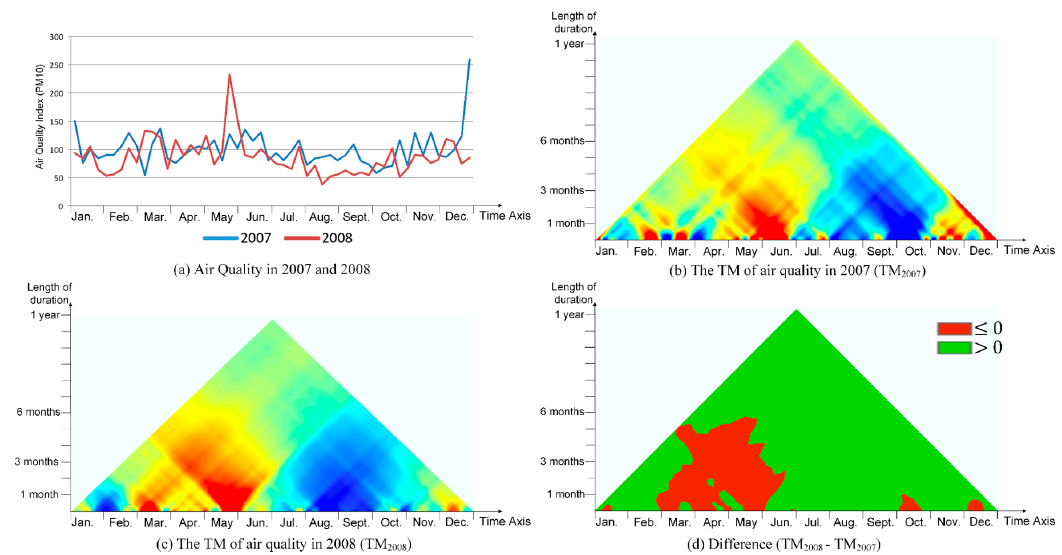
Figure 13. Using map algebra to compare air quality in Beijing in 2007 and 2008. ( a ) Time series of PM10 AQI in Beijing in 2007 and 2008. ( b ) The TM of the 2007 AQI. ( c ) The TM of 2008 AQI. ( d ) The binary result of subtracting the 2007 TM from the 2008 TM (TM 2008 –TM 2007 ).